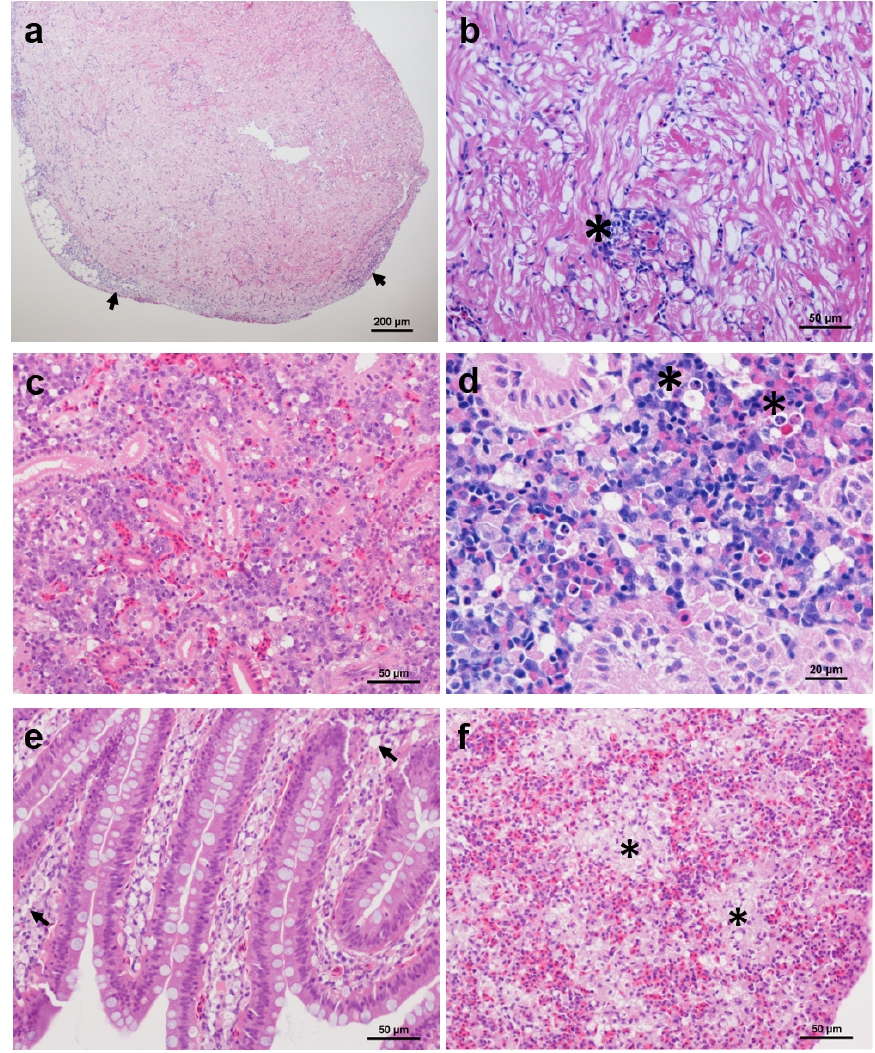
Figure 4. Histopathology associated with chinook salmon bafinivirus Cefas-W054. ( a , b ) Heart section of an intraperitoneally (IP)-injected goldfish showing ( a ) epicarditis (arrows) and ( b ) focal inflammation (asterisk); ( c , d ) Kidney section of an IP-injected goldfish ( c ) and a bath infected common carp ( d ) showing multifocal vacuolisation of haematopoietic tissue and cellular necrosis (asterisks); ( e , f ) IP-injected goldfish showing vacuolisation of the lamina propria (arrows) ( e ) and regions of vacuolated splenocytes (asterisks) ( f ). Haematoxylin and eosin staining was used.